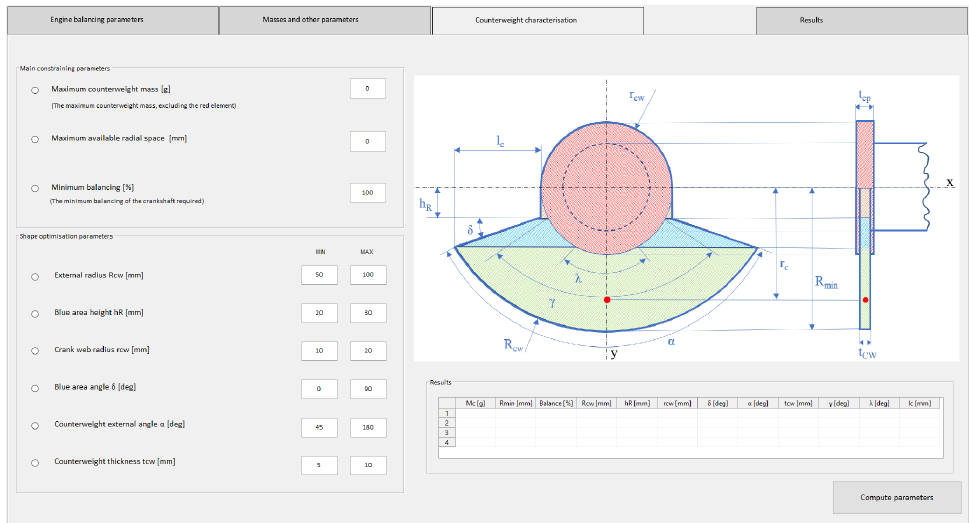
Figure 10. Tab of the user-interface dedicated to the design and optimisation of the